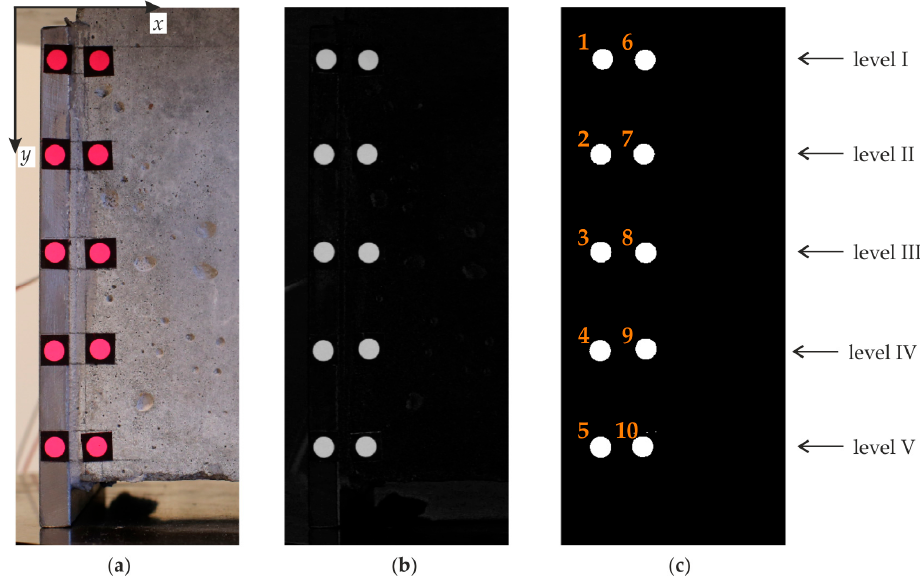
Figure 5. Digital photograph of the left adhesive joint: ( a ) RGB photograph; ( b ) magenta component; ( c ) binary image.